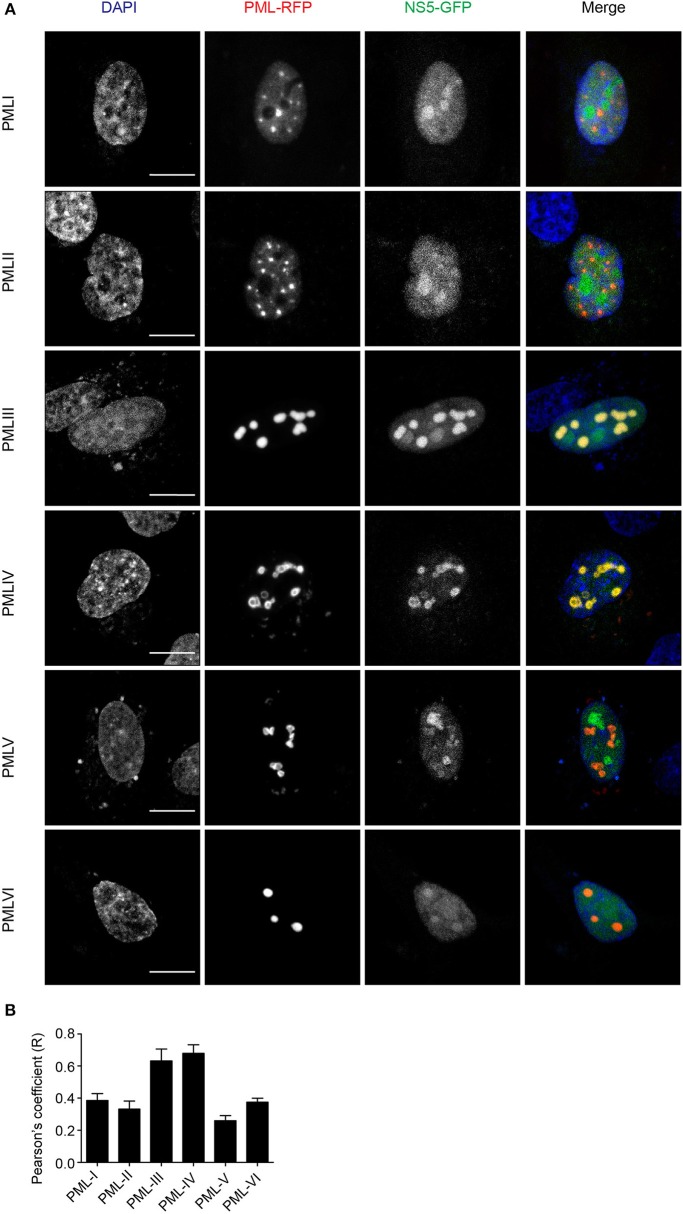
PMLIII-RFP and PMLIV-RFP colocalize with DENV-2 NS5-GFP. (A) A549 cells were co-transfected with vectors encoding one of the six PML-RFP isoforms and DENV-2 NS5-GFP as indicated. At 24 h p.t., cells were fixed and confocal images were acquired using a Zeiss LSM710 setup. Scale bar: 10 μm. (B) Quantification of the Pearson's coefficient was performed using FIJI. At least 10 cells per condition and per experiment were quantified. Data represent the mean ± SD from two independent experiments, performed in triplicate.